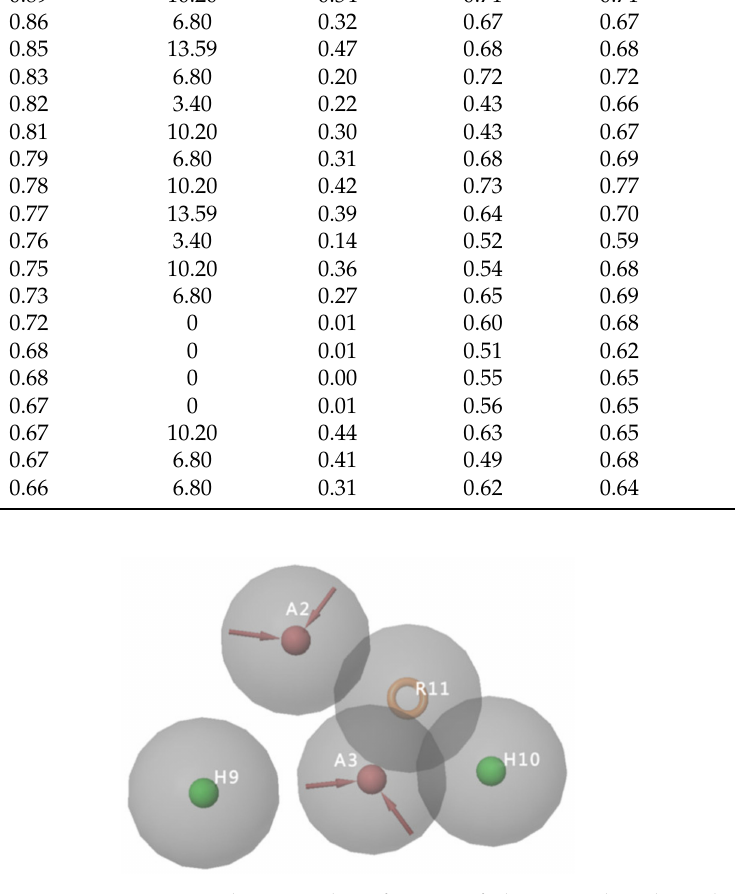
Figure 2. Pharmacophore features of pharmacophore hypotheses